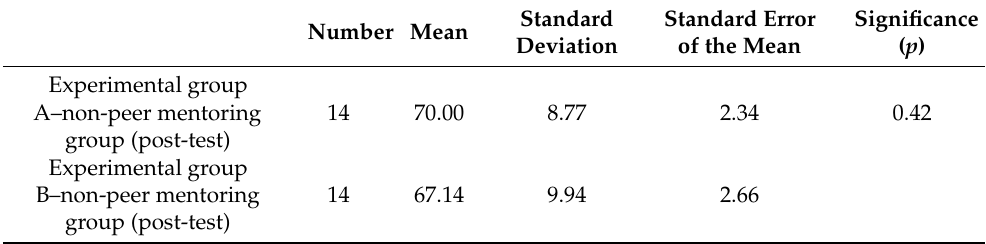
Table 11. Post-test t -test analyses of Experimental group A-non-peer mentoring group and Experi- mental group B-non-peer mentoring group.